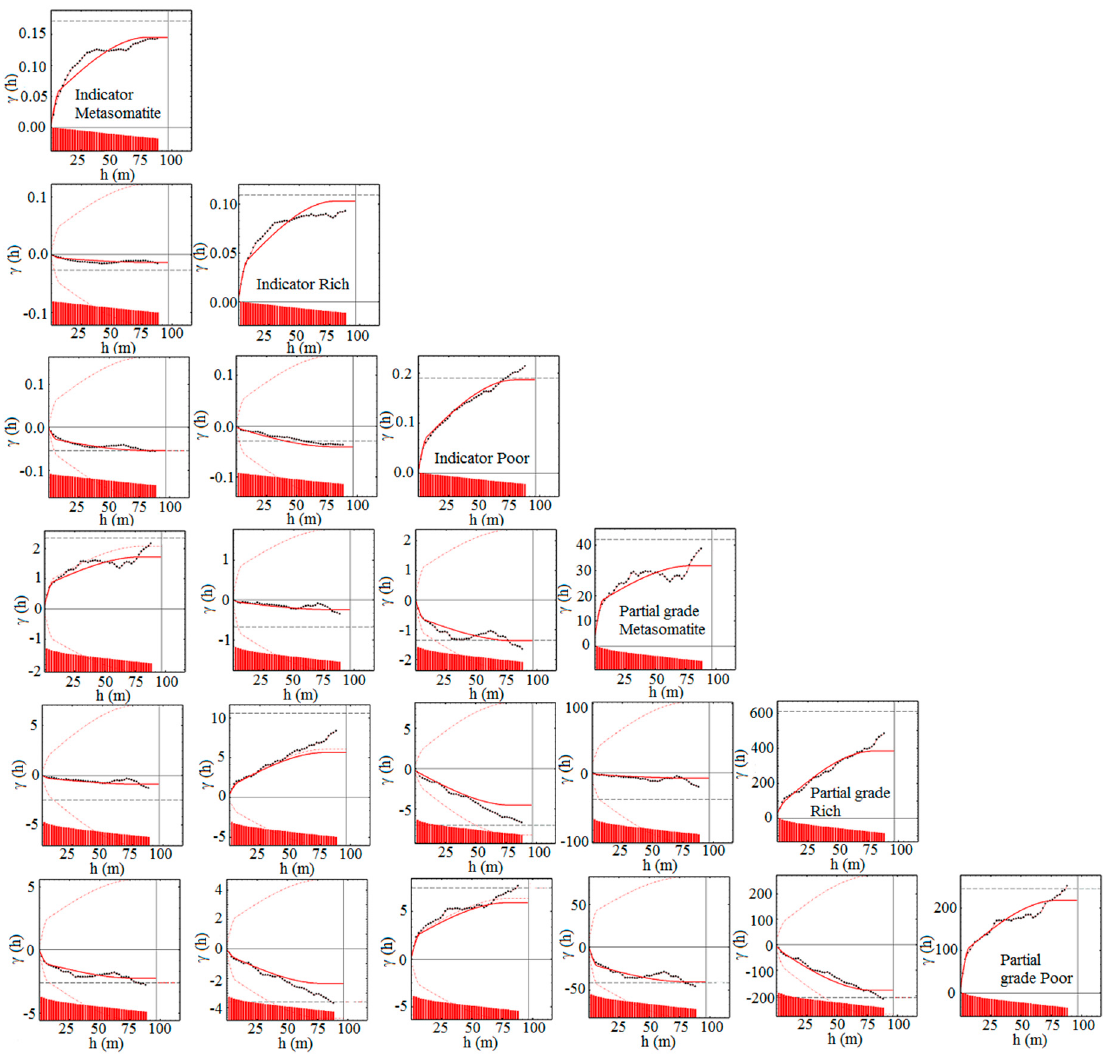
Figure 13. Sample and modeled variograms of indicators and partial grades (direct and cross variograms): Regularized 2.0 m samples in vertical direction.